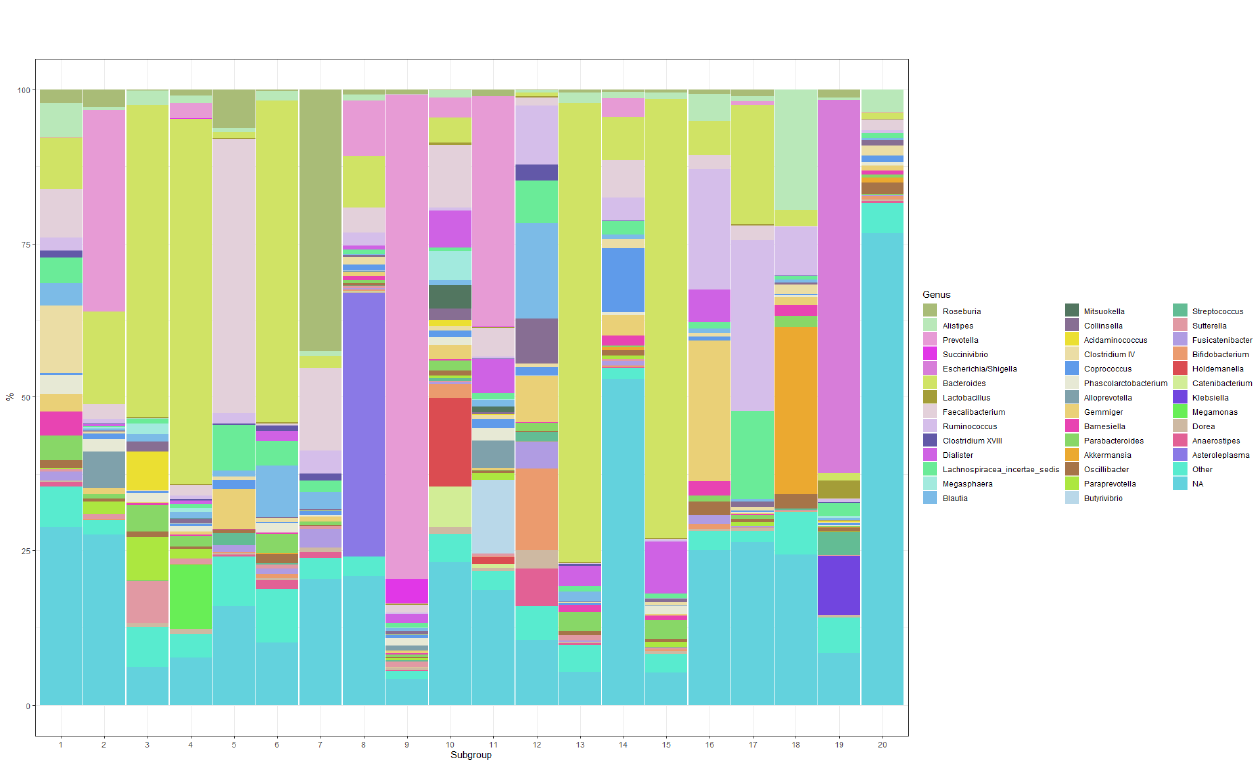
Figure 1. Composition of the 20 microbial subgroups at the genus level (showing the top 40 genera with a probability of at least 2% for at least one subgroup).